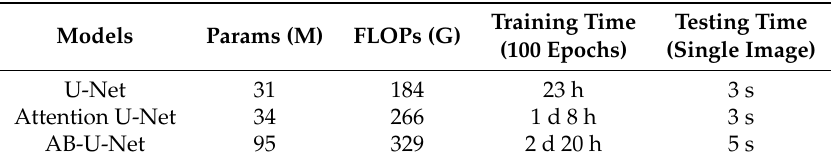
Table 2. The computational complexities of cnn